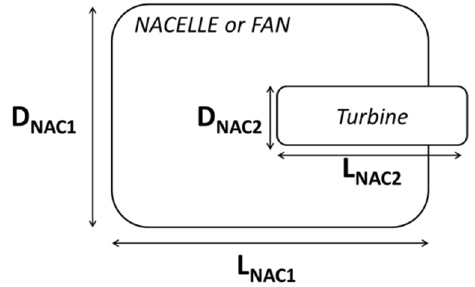
Figure 7. Nacelle types considered in the module.